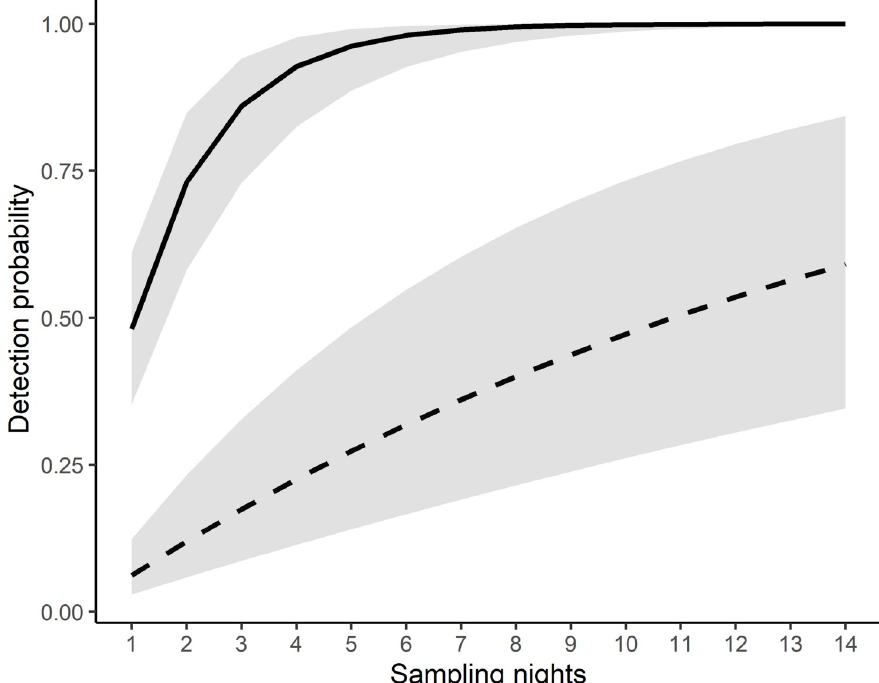
Fig 6. The relationship between the probability of detecting Yellow-bellied Glider vocalisations and the number of sampling nights with no inclement weather (mean score of 0; solid line) and frequent inclement weather (mean score of 3; dashed line). 95% confidence intervals are shaded